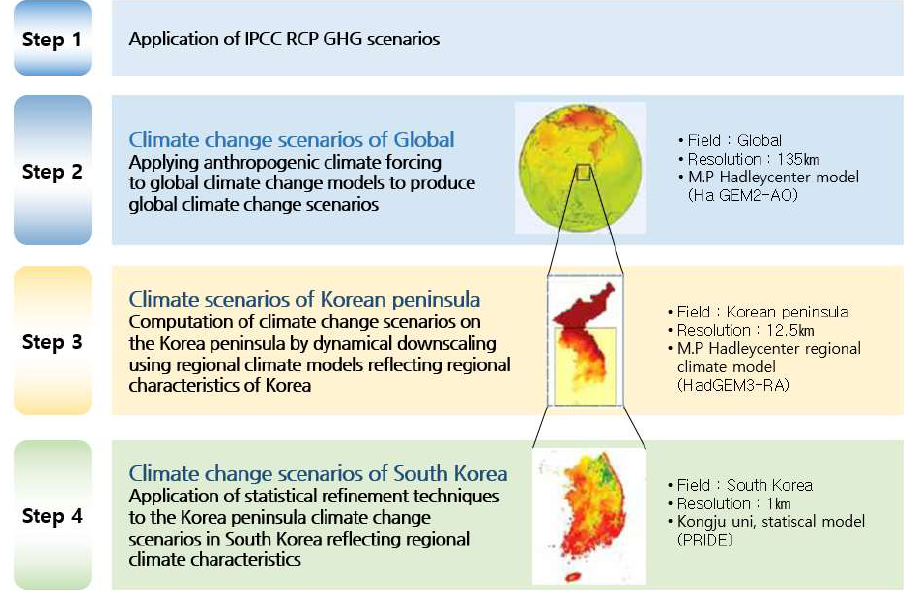
Figure 3. Production process for climate change scenarios [13]. In this study, the RCP 4.5 scenario was simulated for the peninsula for 200 years with 12.5 km resolution, and the integral control was based on the RCP 8.5 scenario. The ex- traction of annual maximum daily rainfall data was based on the past observed time series of daily rainfall (1988–2018) and the climate change scenarios from 2019 to 2100. The annual maximum daily rainfall for the next 100 years suitable for the EDC, the research study area, was analyzed and used as shown in Table 1. Table 1. Annual maximum daily rainfall according to climate change scenarios.